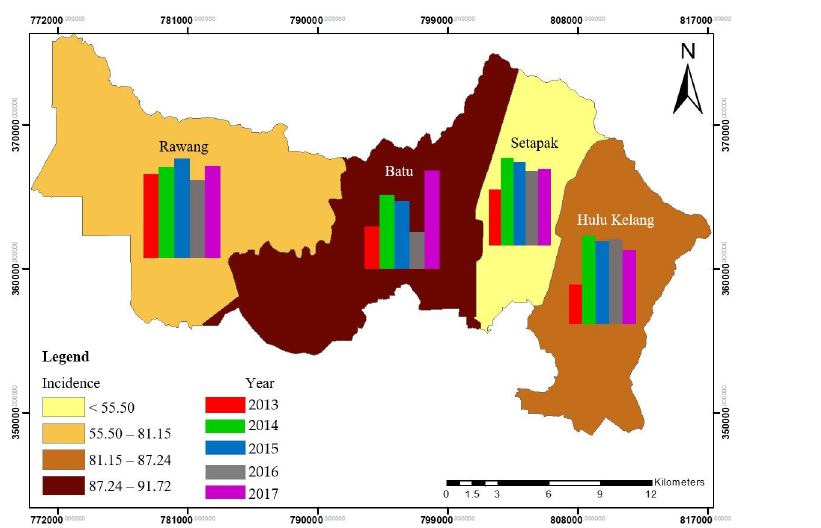
Fig 4. Average incidence rate of TB from 2013 to 2017 at the mukim level in